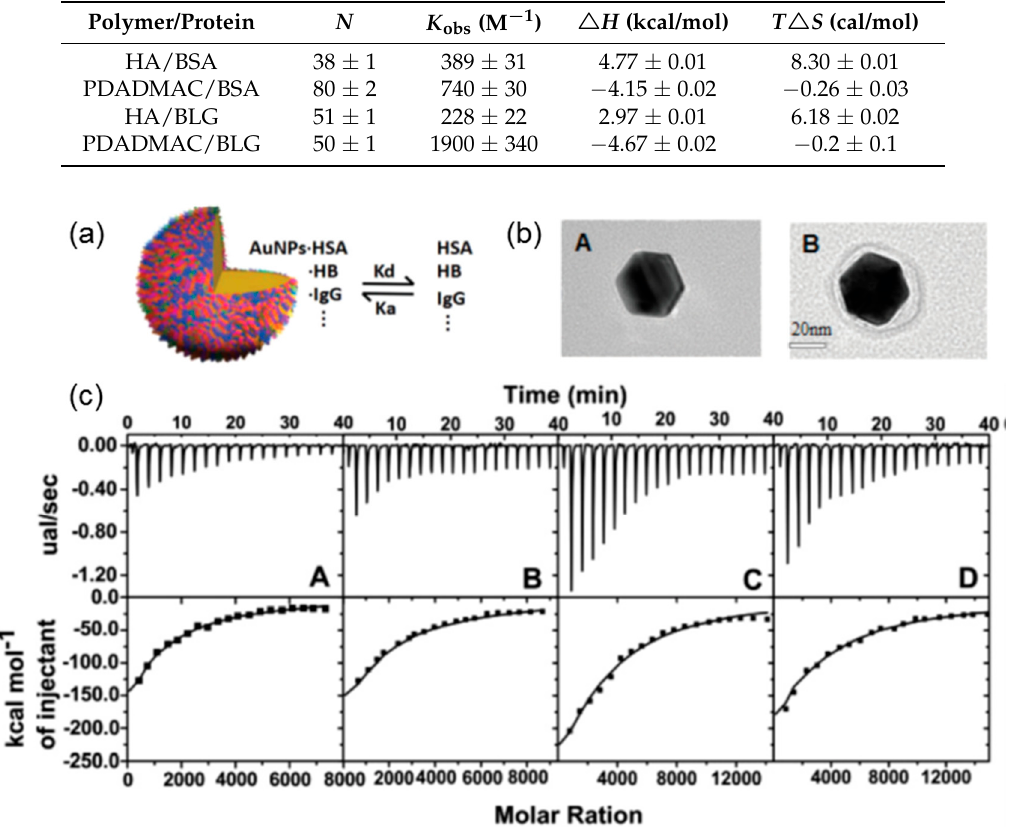
Table 1. Thermodynamic properties obtained from the independent site-binding model for polymer − protein interactions. Conditions for poly(dimethyldiallylammonium chloride) (PDADMAC)/protein and hyaluronic acid (HA)/protein are pH 5.3, I = 100 mM and pH 4.3, I = 100 mM, respectively. BLG— β -lactoglobulin. The data was taken from the works of [30,32]. Polymer/Protein